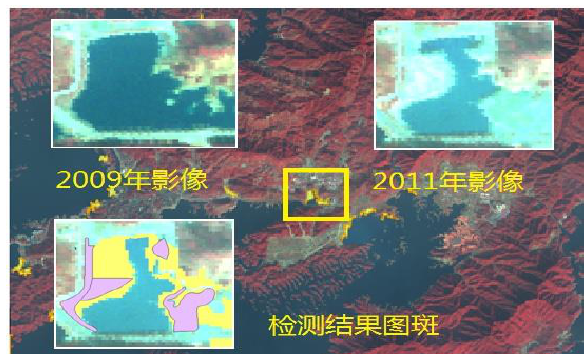
Figure 6. Changed Water Detection